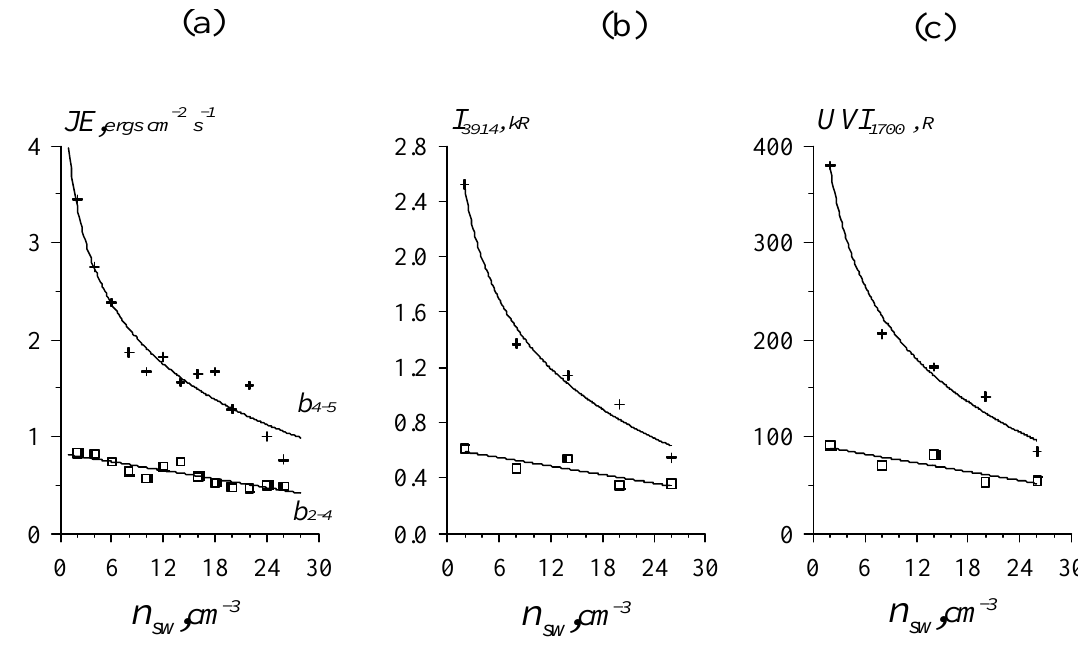
Fig. 3. Changes in the electron energy flux (a) and the calculated intensity of 391.4nm (b) and LBH-long (c) bands in b 2 i – b 4 s and b 4 s – b 5 regions in the pre-midnight sector during periods of the IMF B z > 0, depending on the solar wind plasma density.